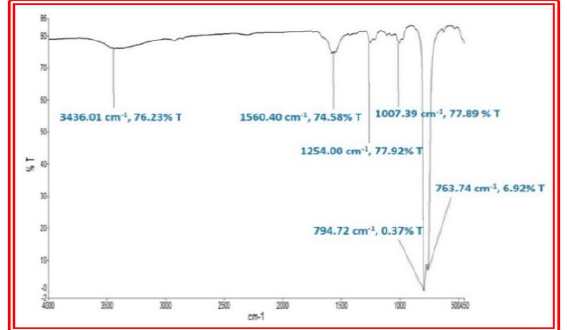
Figure 7. FTIR spectroscopy of chickpea peptide.